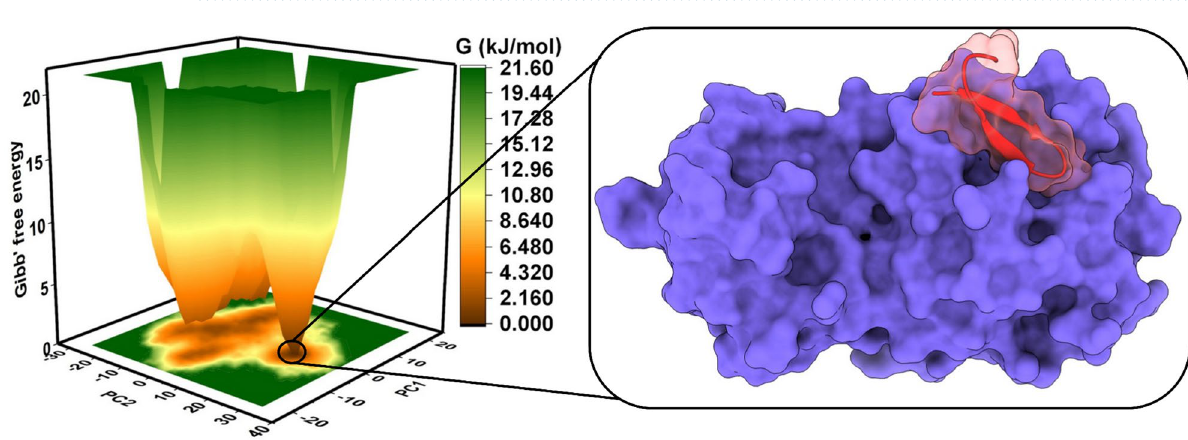
Figure 5. The Gibbs free energy landscape of M pro -BRIP complex showing the metastable conformation at the lowest energy